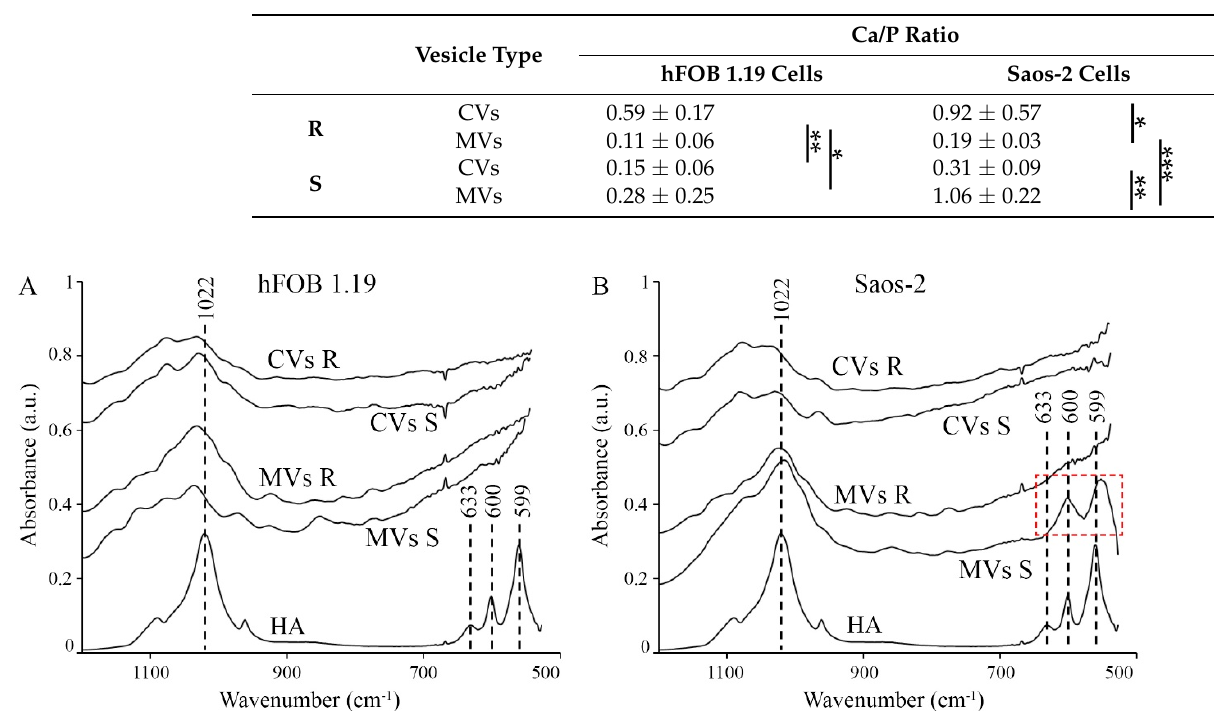
Figure 3. IR spectra of minerals formed by vesicular fractions of hFOB 1.19 ( A ) and Saos-2 ( B ) cells. Vesicular fractions were purified from the extracellular matrix (MVs) and from the cytoplasm (CVs) of collagenase-treated cells in resting conditions (R) or after stimulation with AA and β -GP (S). The vesicular fractions were dried. IR spectrum of apatite (HA) is characterized by peaks 1022, 633, 600, and 559 cm − 1 . The red rectangle indicates the presence of HA in the fraction of MVs derived from the Saos-2 cell line stimulated for mineralization. IR spectra were averaged from three independent samples, each measured at two distinct locations of the batch (n = 6). IR spectra were up scaled by 0.2 A to be better visible. Table 1. Ca/P ratio calculated for vesicular fractions derived from extracellular matrix (mostly MVs) and cytoplasm (CVs) of collagenase-treated hFOB 1.19 or Saos-2 cells in resting conditions (R) or after stimulation with AA and β -GP (S). Data are means ± s.e., n = 8–18 measurements of three independent experiments (* p < 0.05, ** p < 0.01, and *** p < 0.001). Ca/P Ratio Vesicle Type hFOB 1.19 Cells Saos-2 Cells CVs 0.59 ± 0.17